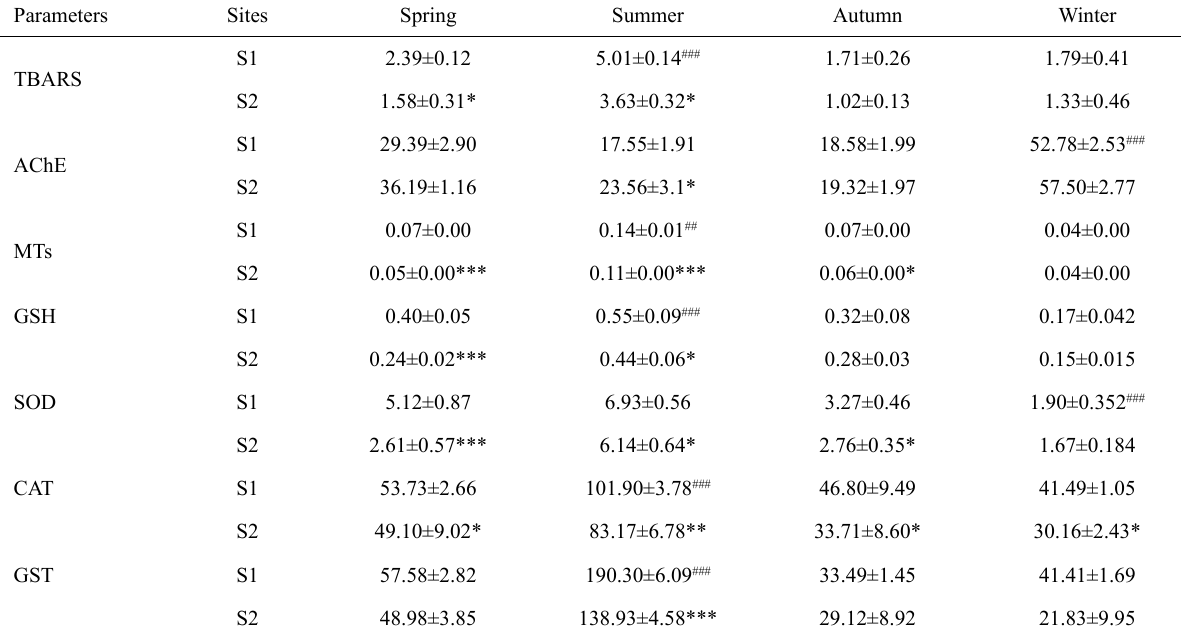
3. – Seasonal variation in the oxidative stress biomarkers in P. cultrifera tissues collected from the port of Rades (S1) and the Punic port of Carthage (S2).